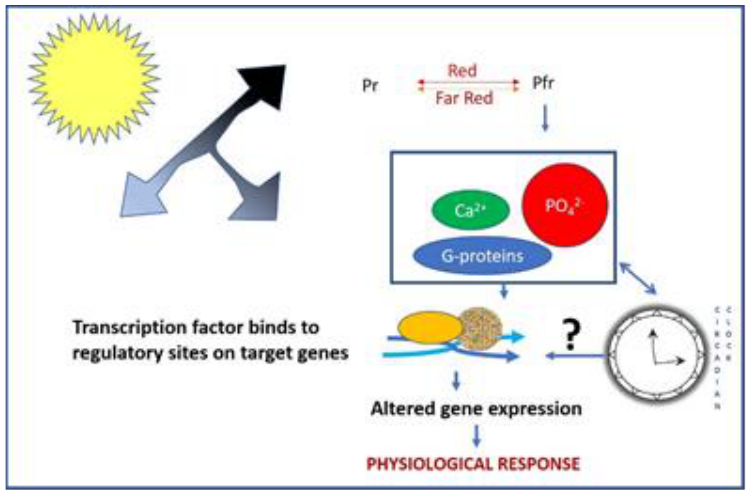
Figure 1. Mode of action of phytochromes in light perception in plants. The inactive Pr form in cytosol is converted to an active Pfr form by the absorption of red light, which, upon irradiation, moves to the nucleus to interact with numerous cell components to cause physiological changes in response to light. The Pfr form of phytochromes can absorb far-red light and then return to the Pr form, which implies a Pr/Pfr photo-reversibility, in which phytochromes operate as toggle switches that turn on with R light and off with FR light.